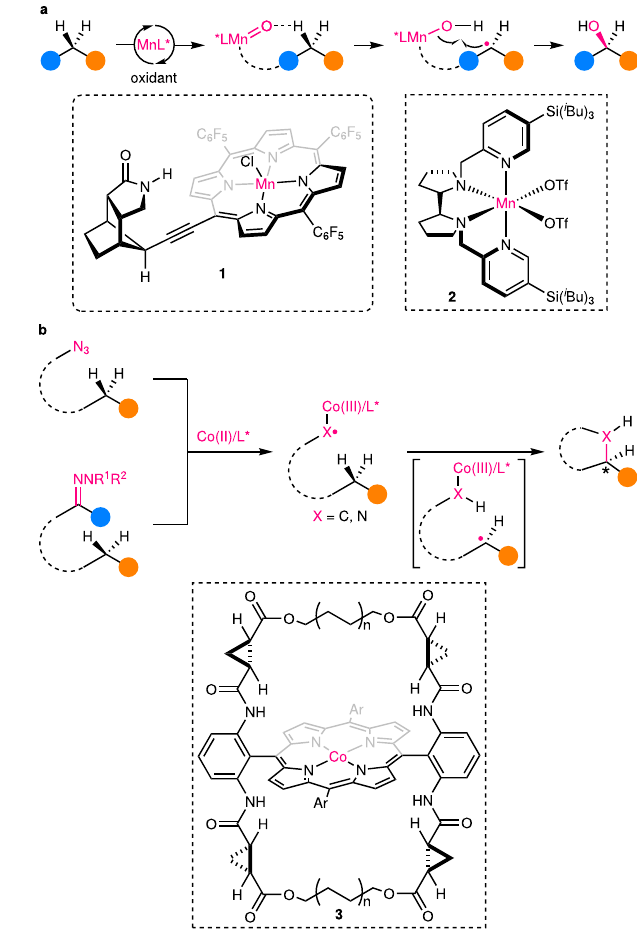
Fig. 3 Examples of catalytic enantioselective C( sp 3 ) – H functionalization with enantiodiscriminative HAA. a Mn-catalyzed enantioselective hydroxylation of secondary C( sp 3 ) – H bonds. b Co-catalyzed enantioselective amination/alkylation of secondary C( sp 3 ) – H